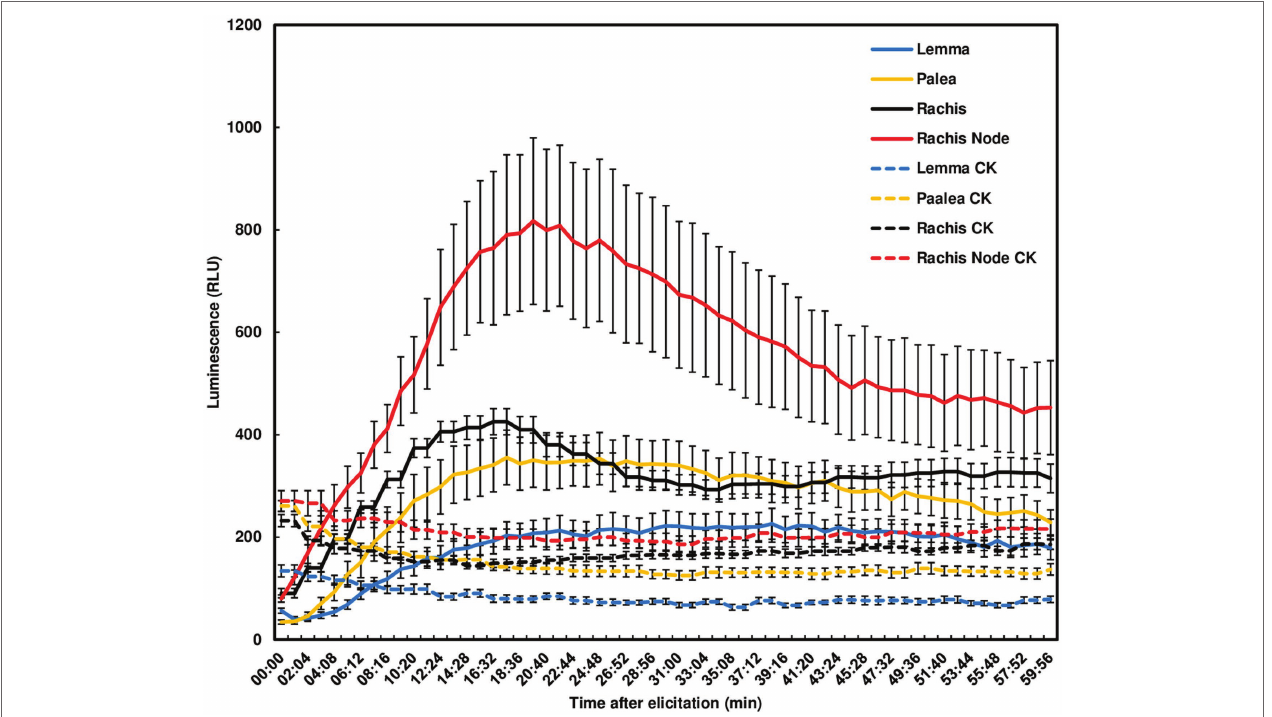
FIGURE 2 | Chitin-triggered ROS in wheat head tissues. Spikes from the wheat variety, Norm, at mid-anthesis were dissected. Lemmas, paleae, rachises, and rachis nodes were used for ROS assays. Chitin (100 μ g/ml) was used for treatment. The wells omitting chitin served as controls (CK). ROS were monitored using a chemiluminescence assay with L012 as a substrate. Signals (RLU) were recorded for 60 min after treatment. The data represent means ± standard error ( n = 12) for each variety. The experiments were repeated three times with similar results.